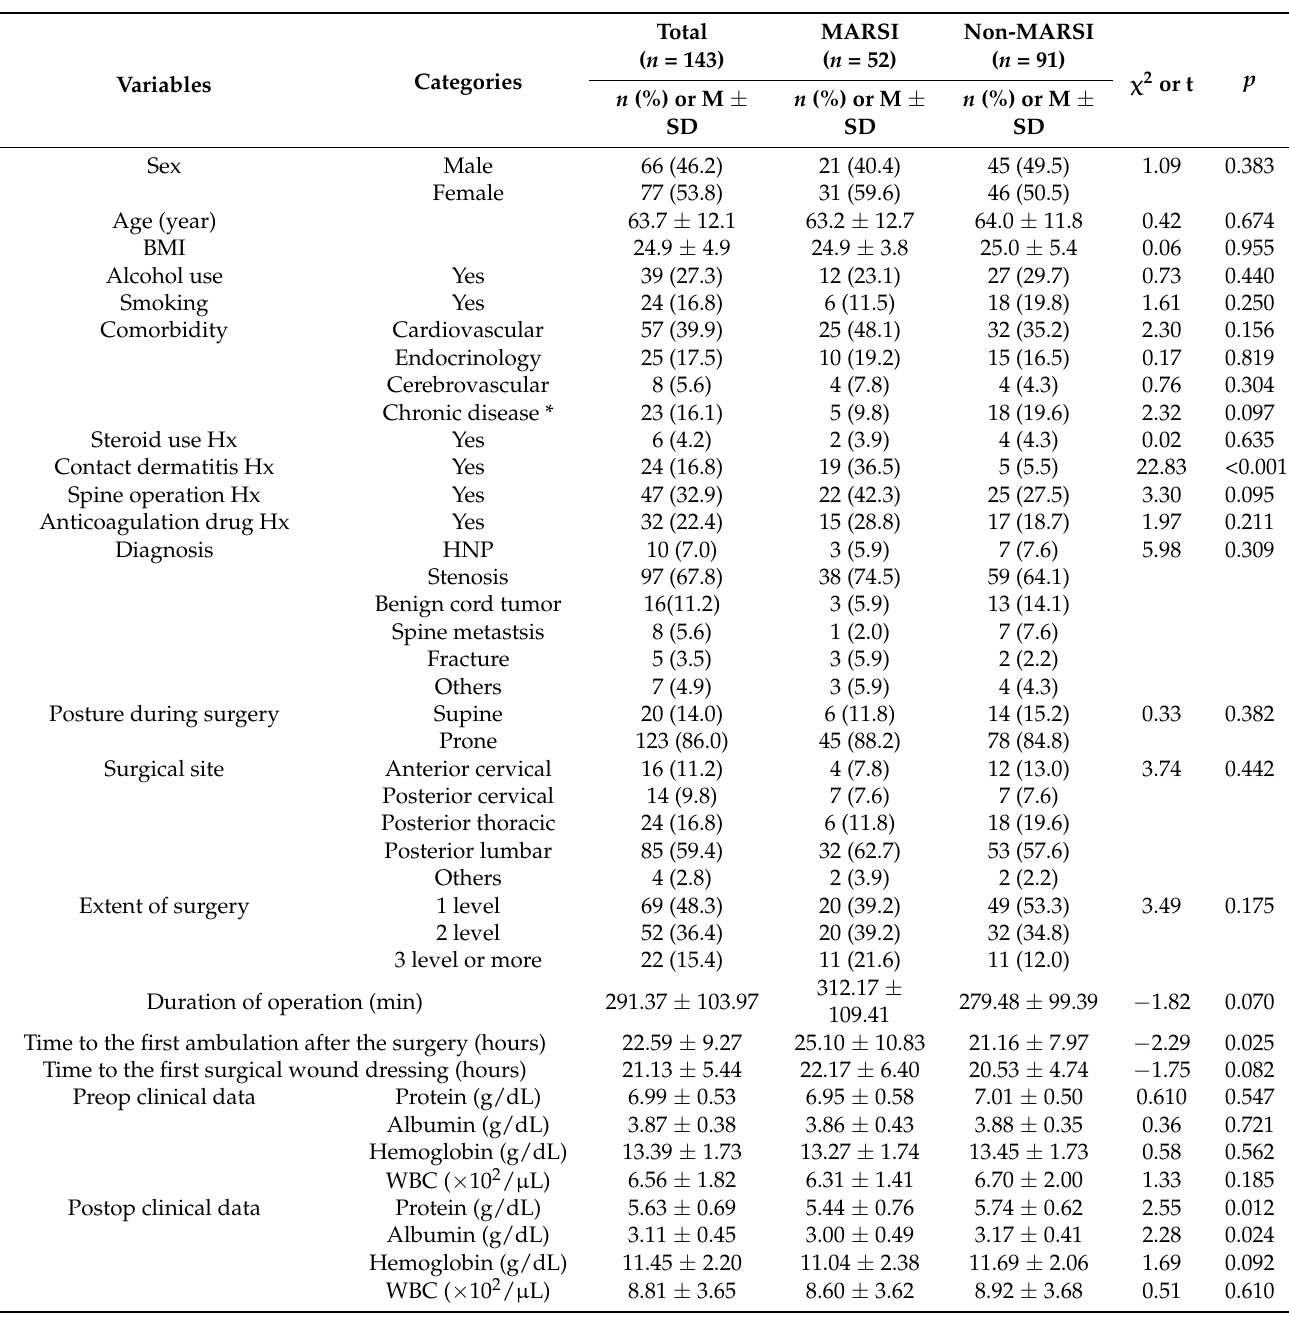
Table 1. Participant characteristics. ( n =